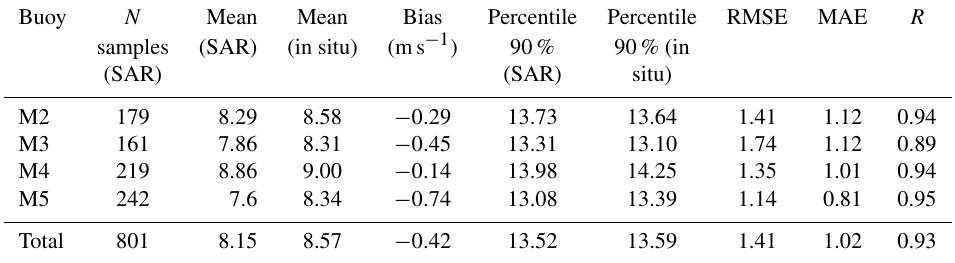
Table 4. Results of the match-up comparison of satellite-measured wind speeds with in situ measured wind speeds from weather